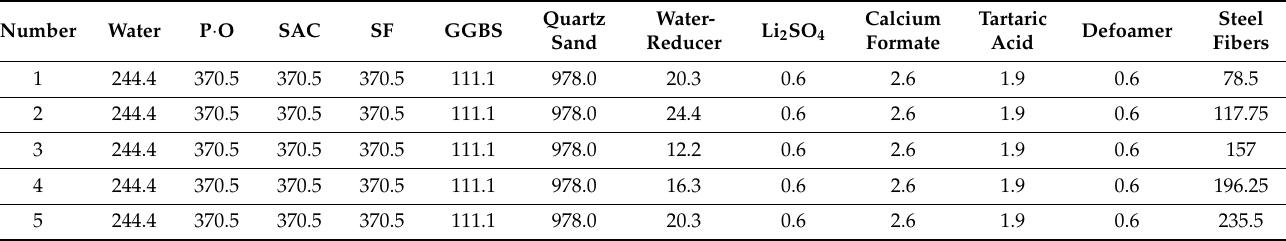
Table 3. The mixing proportions of RPC per one cubic meter